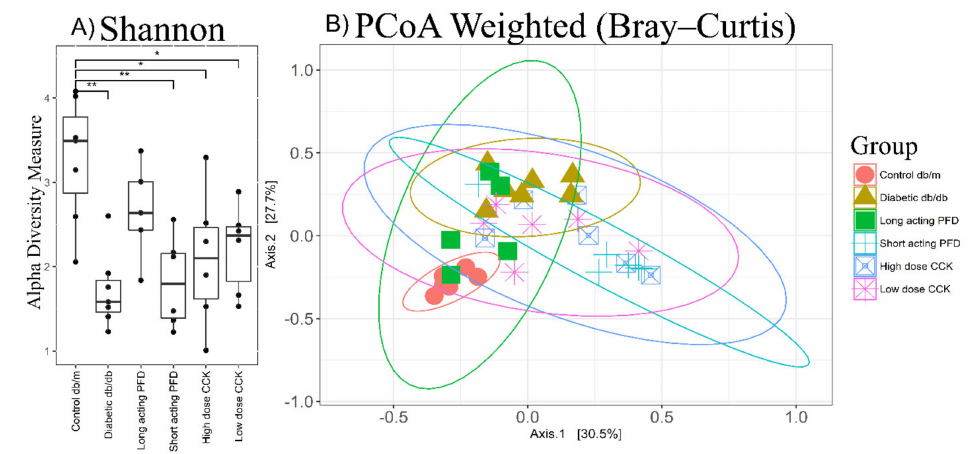
Figure 2. ( A ) Alpha diversity plot displaying the Shannon index for di ff erent groups with x-axis represents the Shannon index. Significance levels between two groups is indicated by stars (* 0.01 to 0.05, ** 0.001 to 0.01) and no comparison / stars mean no statistical significance was found between groups. High alpha diversity represents a healthy gut microbiome. ( B ) Principal coordinate analysis (PCoA) plot showing the control db / m clustering separate than db / db mice but overlapping with long-acting-PFD-treated db / db mice. The x- and y-axes represent the first and second components of the PCoA plot,